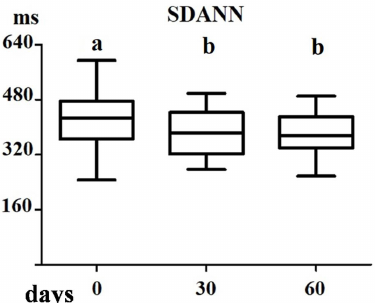
Figure 5. Comparison between the mean values in milliseconds (ms), as a function of days, regarding the SDANN value before and after rhinoplasty surgery. Different letters (“a” and “b”) along the one of the columns indicate significant difference at 5% level.